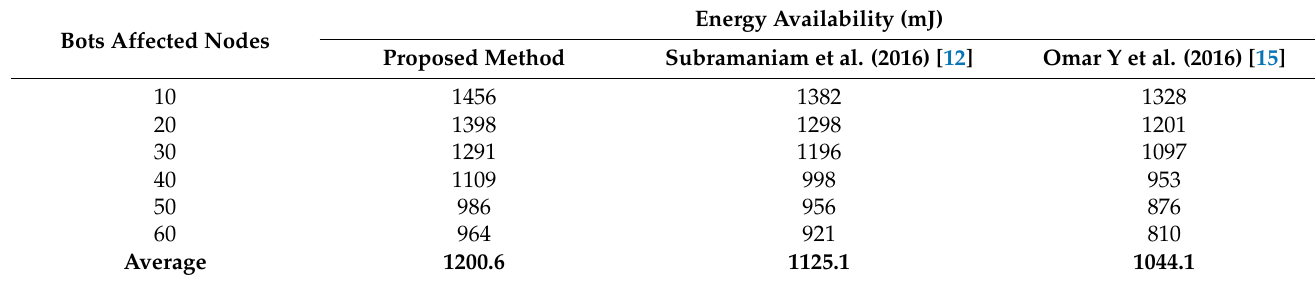
Table 6. Comparisons of Energy